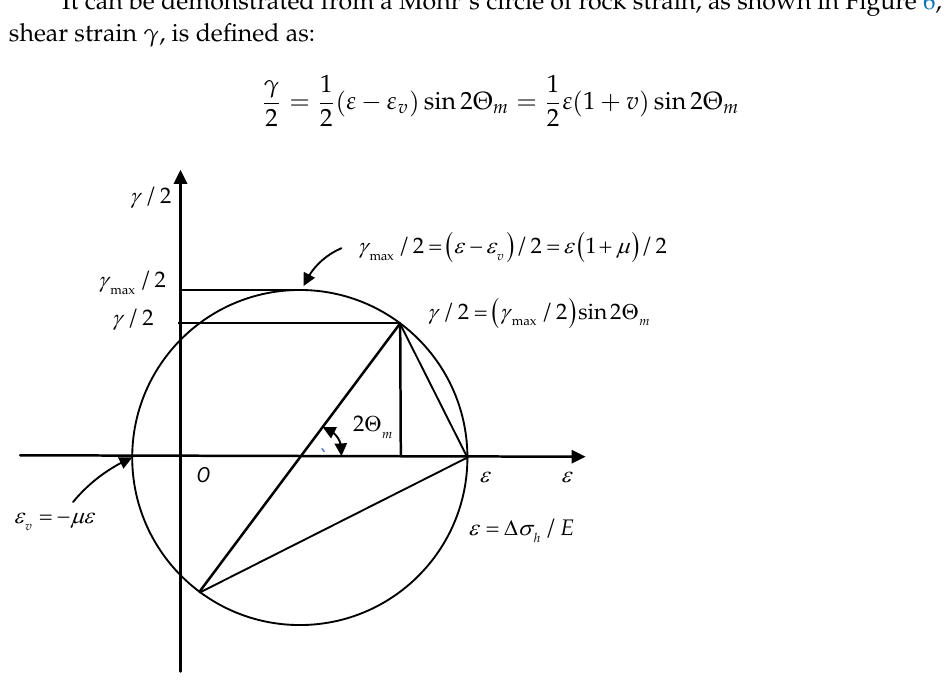
Figure 6. Associated Mohr Circle of Strain.